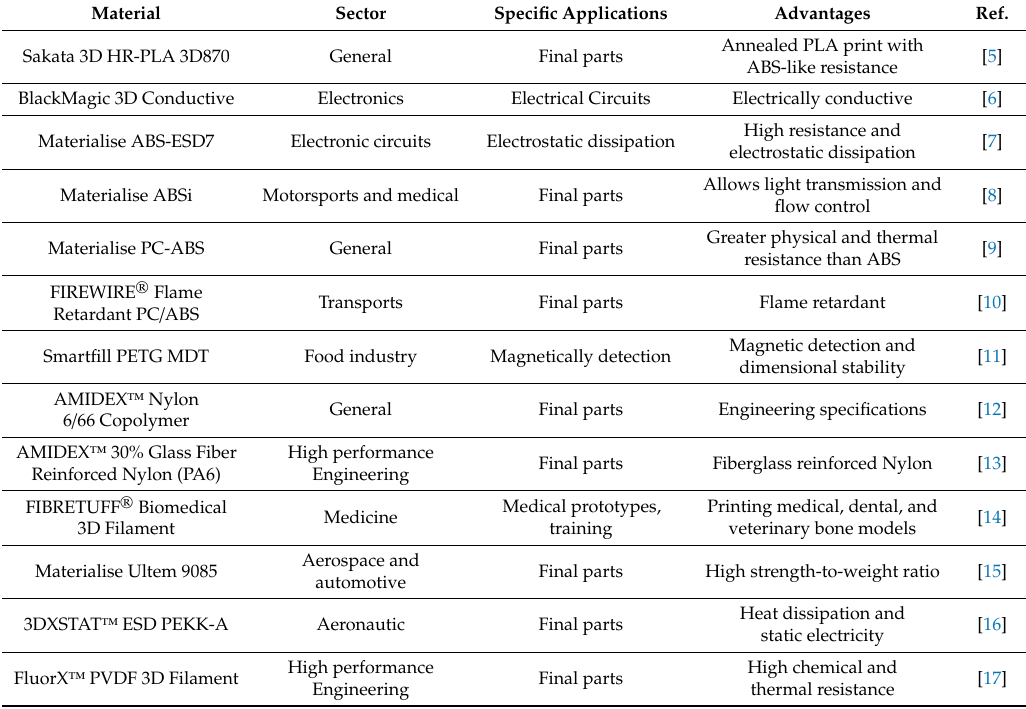
Table 1. Examples of ME thermoplastic materials and their targeted sector and specific applications.